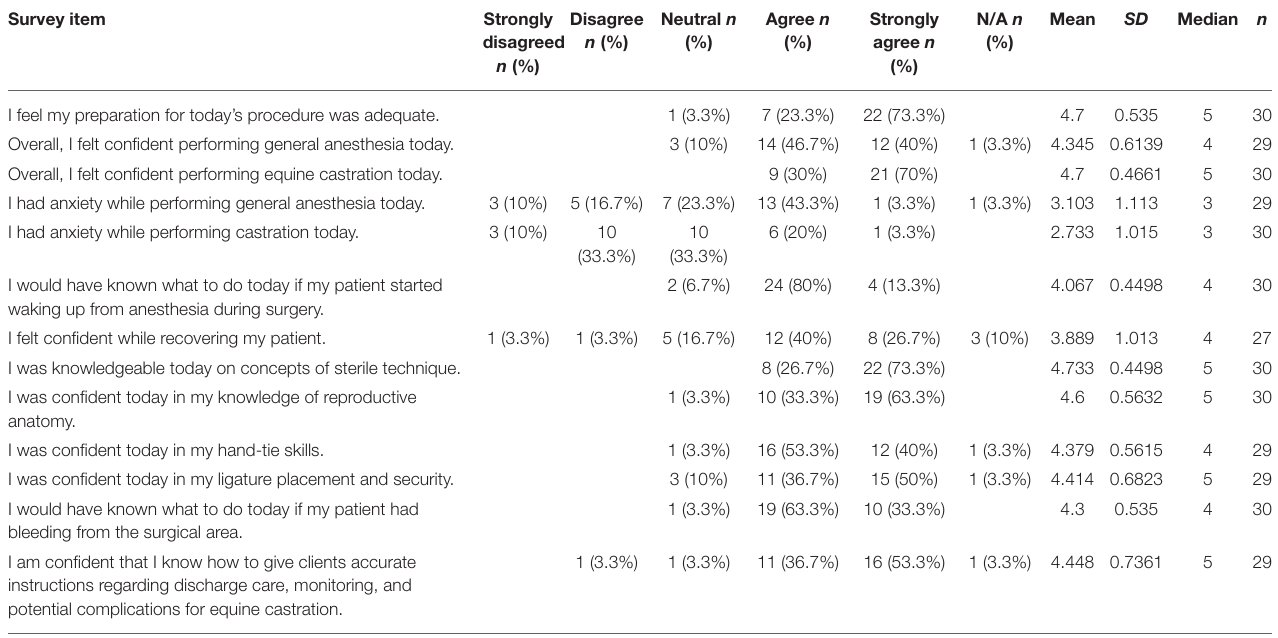
TABLE 6 | Student confidence survey, post-castration, with model experience. Survey item